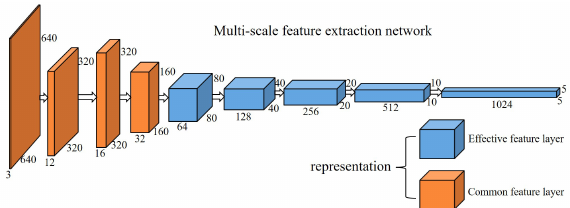
Fig. 5. Structural diagram of the CBAM attention